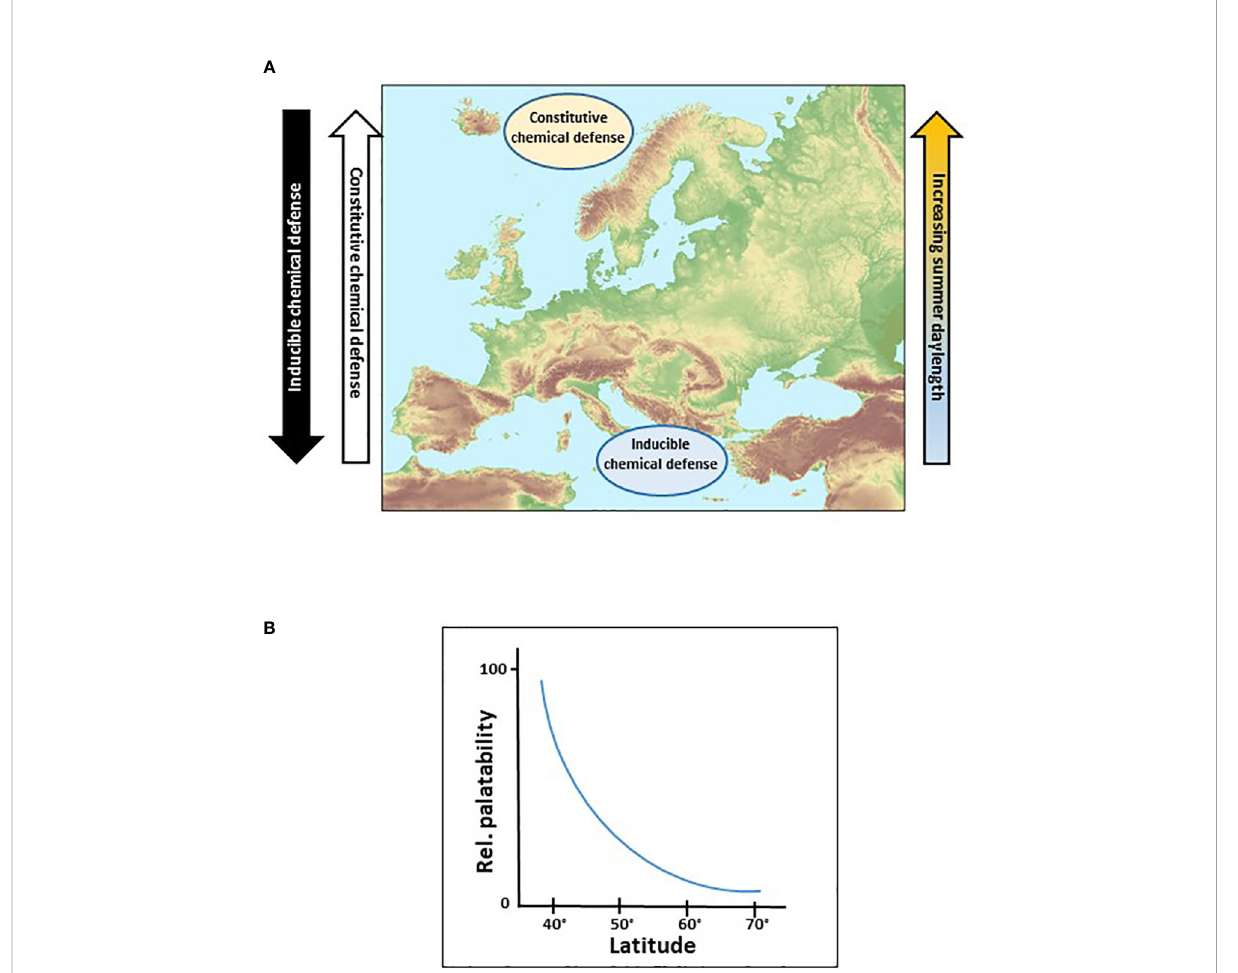
FIGURE 1 Hypothetic distribution of plant chemical defenses along latitudinal gradients. (A) Variability of chemical defenses along latitudinal and their corresponding daylength gradients. (B) Proposed decrease of palatability for herbivorous insects feeding on leaves with increasing latitude. © Map of Europe in (A) European Environment Agency